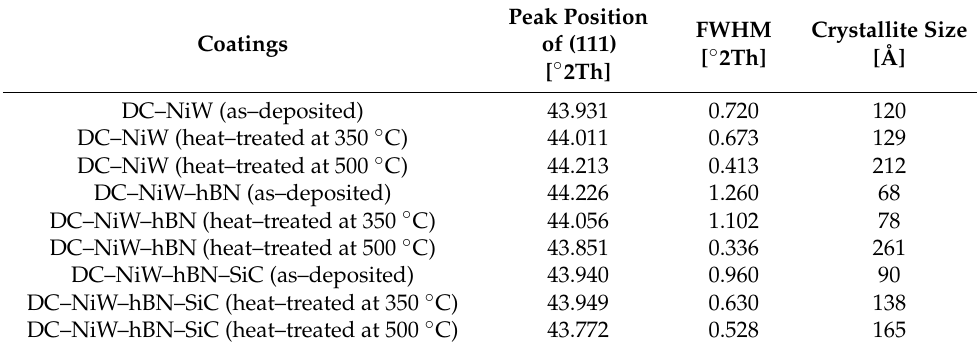
Table 4. Crystallite sizes of DC-deposited NiW, NiW–hBN, and